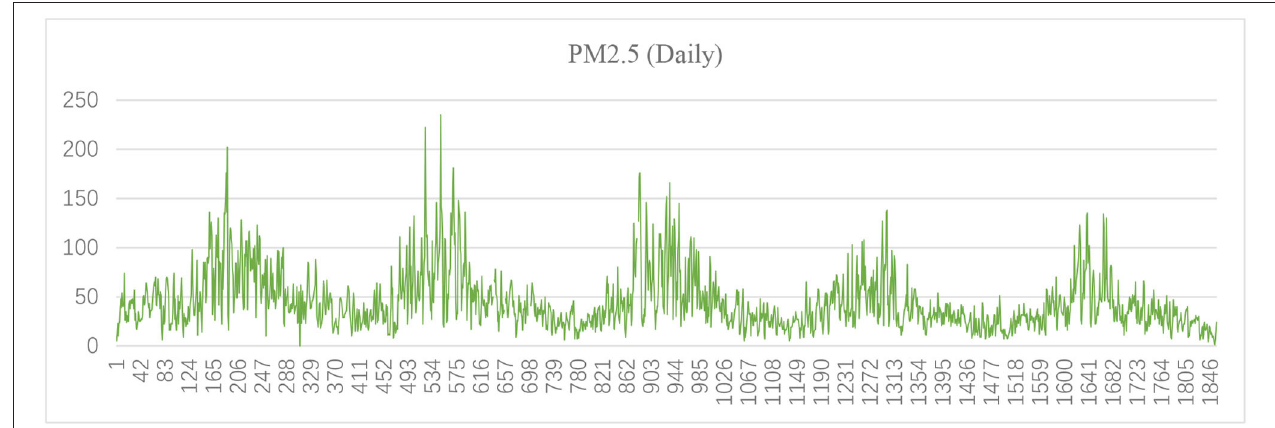
FIGURE 1 | Daily PM2.5 of Hefei from July 2016 to July 2021 ( µ g/m 3 ).